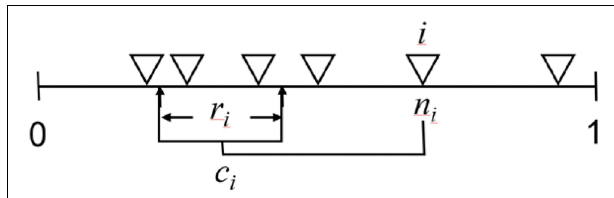
FIGURE 3 | Diagram of the niche model from Williams and Martinez (2000). This model formalizes the theory that the primary mechanisms responsible for food-web structure are the bioenergetic processes that create a trophic hierarchy based on autotrophs from herbivory through omnivory and carnivory and biophysical processes that constrain consumers to feed on species within a contiguous section of this hierarchical niche space. The one-dimensional axis from 0 to 1 represents this community niche space. The model’s two input parameters are the number of species ( S ) and complexity in terms of directed connectance ( C = # of links/ S 2 ). Each of S species (e.g., S = 6, each shown as ∇ ) is assigned a random “niche value” ( n i ) drawn uniformly from